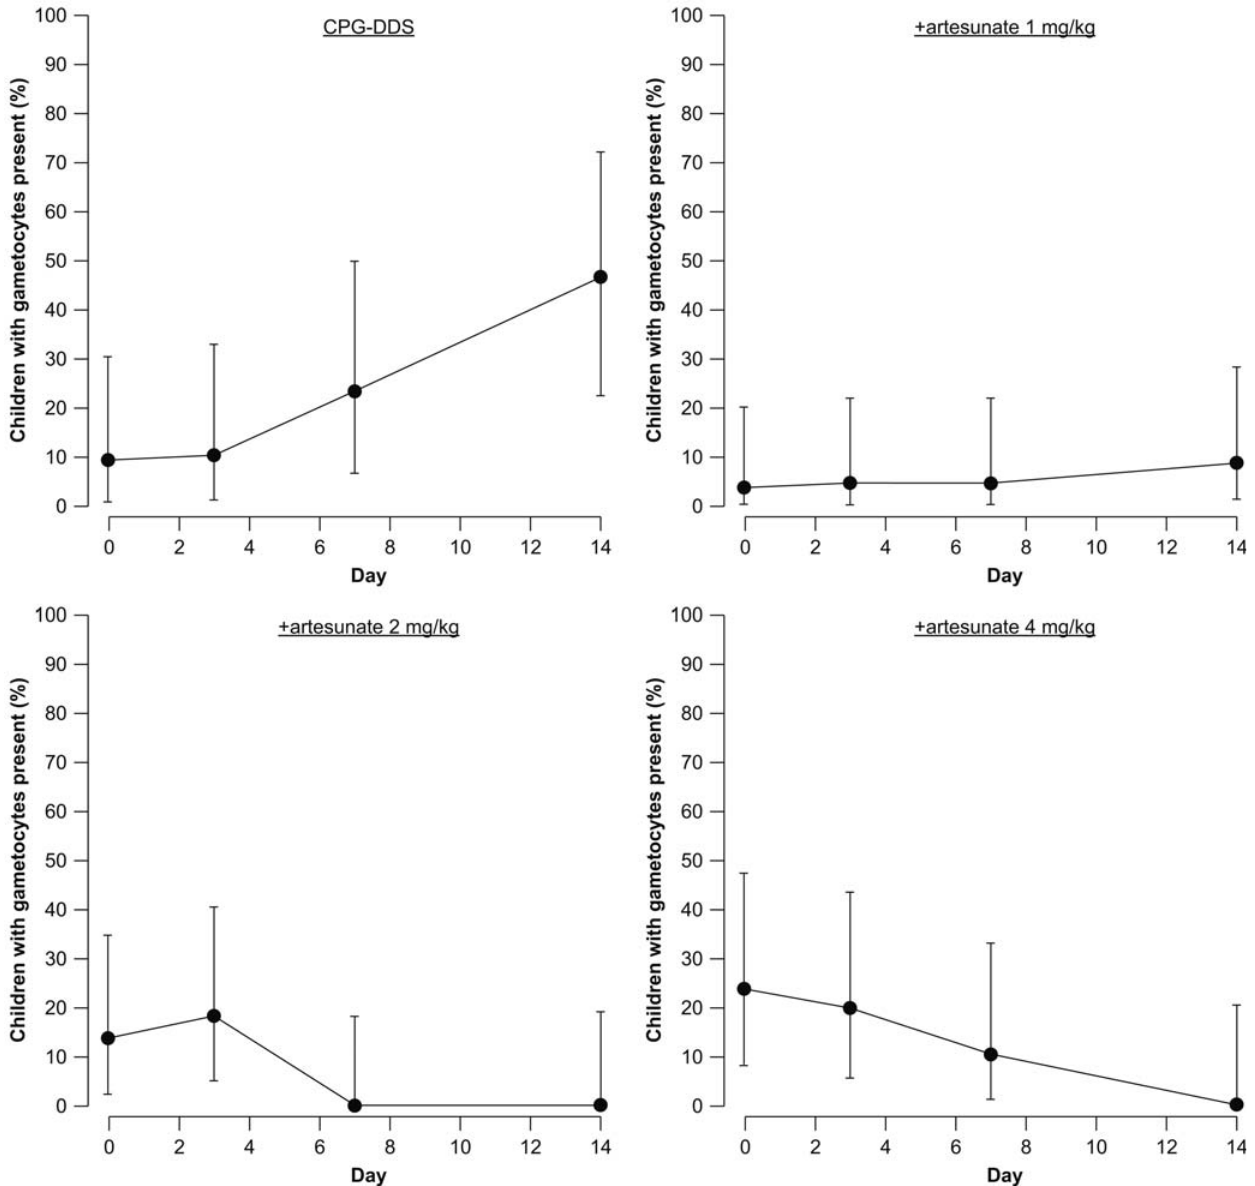
Figure 5. Children: Percentage of patients who were gametocytemic in the Day 3 per-protocol population at each scheduled assessment time.